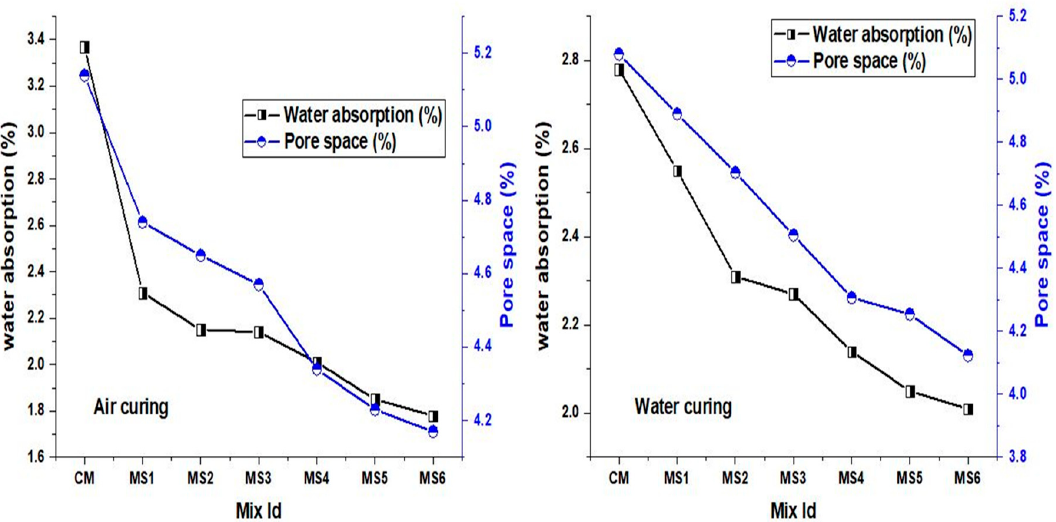
Figure 9. Water absorption and pore space of the air cured and water cured polymer concrete mixes.